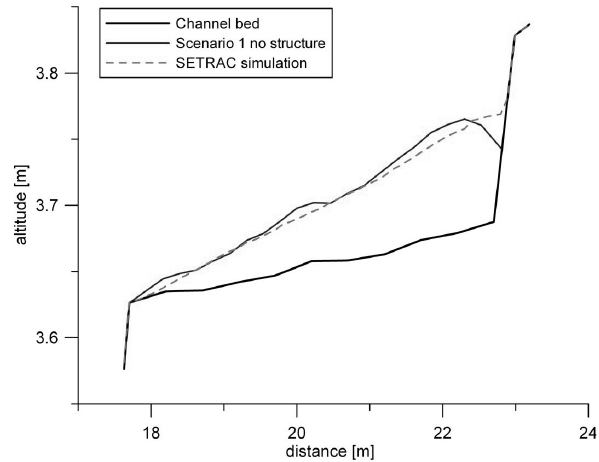
Fig. 7. Comparison of modelled (SETRAC) and measured deposi- tion heights for Scenario 1 and the no structure configuration.